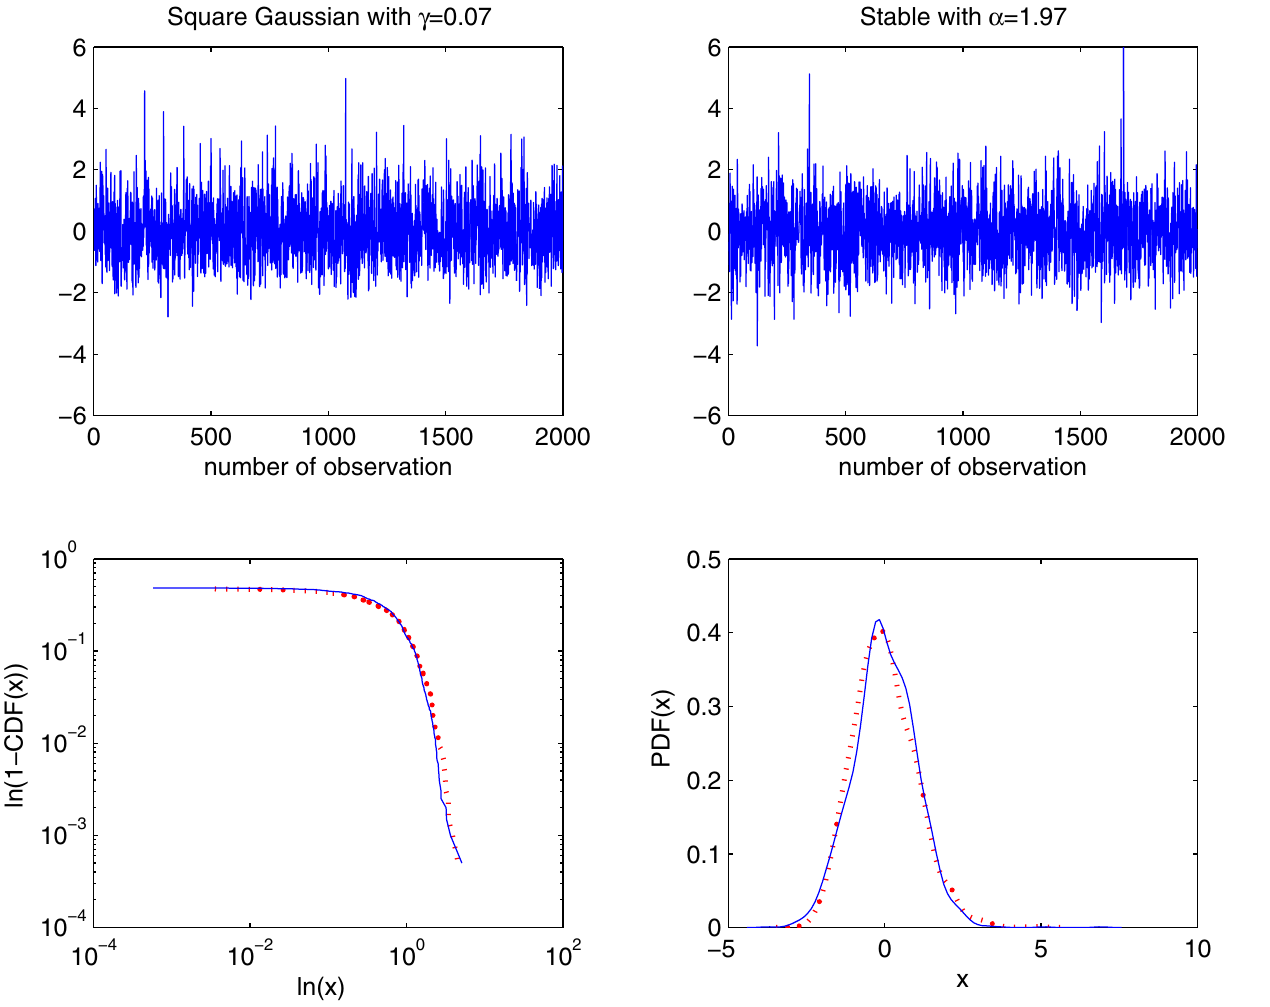
Fig 5. Simulated samples from the square Gaussian distribution with γ = 0.07 (top left panel) and stable distribution with α = 1.97, β = 1, σ = 0.7 and μ = 0.1 (top right panel), and their empirical tails in log-log scale (bottom left panel) and PDFs (bottom right